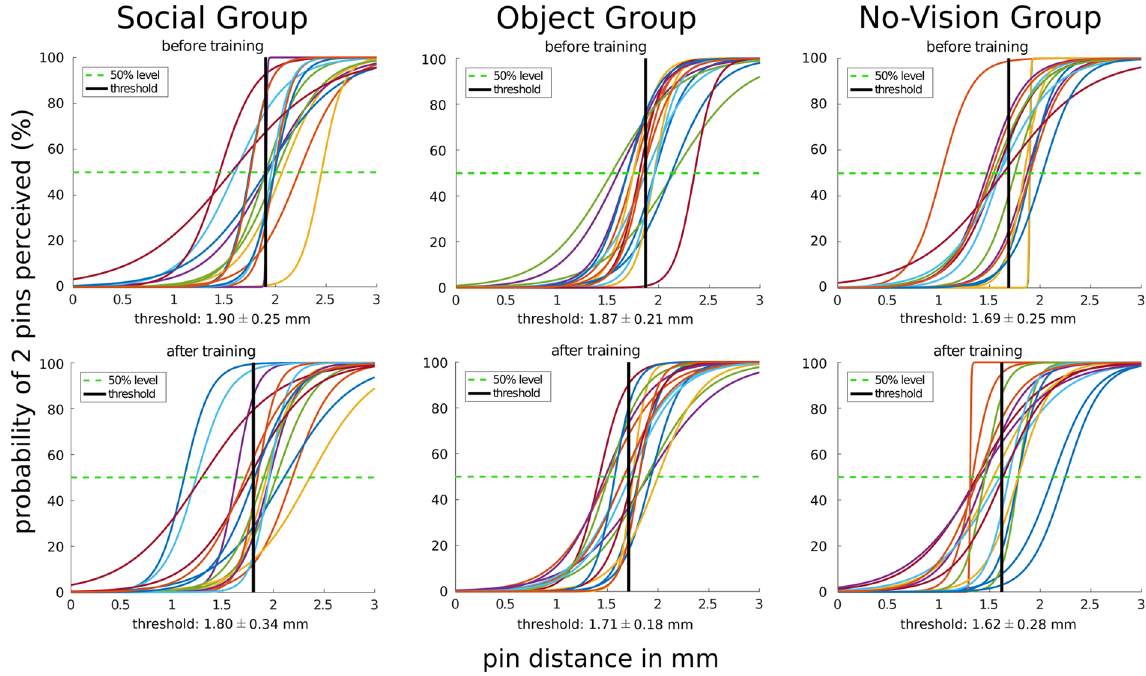
Figure 1. Fitted psychometric functions of N = 48 individual participants who took part in the initial training experiment (n = 16 in each group). Probabilities of “two” - responses are plotted against ascending pin distances. Group mean two-point discrimination thresholds at the 50% probability level are indicated as black lines. Sigmoid curves are plotted with a sampling rate of 0.01 mm within a range from 0 to 3